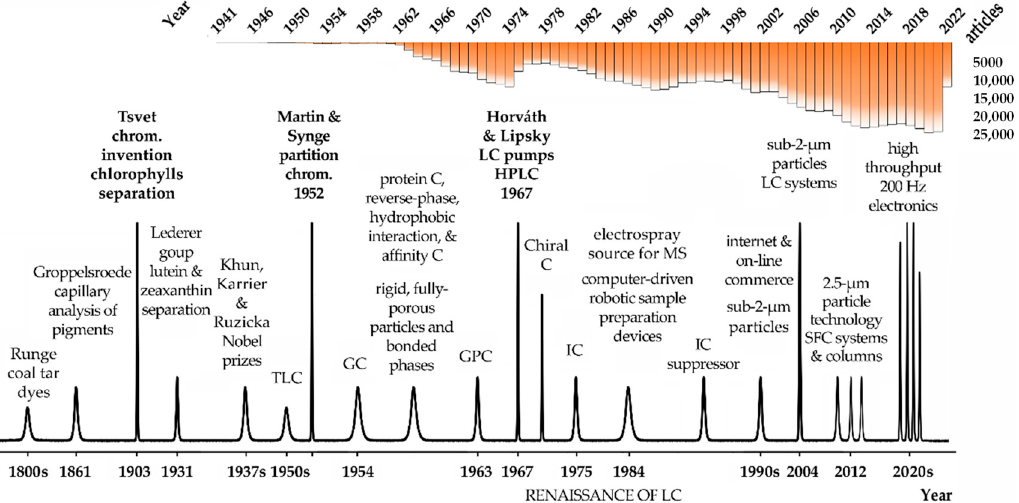
Figure 1. Overview of major milestones in the evolution of chromatography. The number of articles published in the literature according to PubMed servers and using the keyword chromatography are indicated in the top part of the figure. Legend: C—chromatography, GC—gas chromatography, GPC—gel permeation chromatography, HPLC—high-performance liquid chromatography, IC—ionic chromatography, LC—liquid chromatography, MS—mass spectrometry, SFC—supercritical fluid chromatography, TLC—thin-layer chromatography.